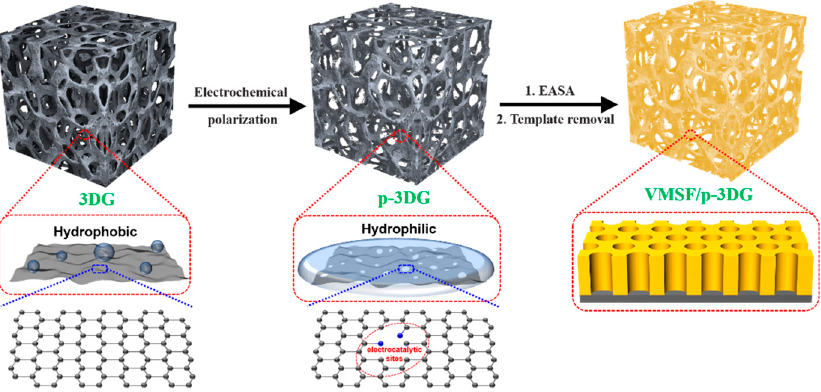
Figure 1. Schematic illustration for the fabrication of VMSF/p-3DG sensor.